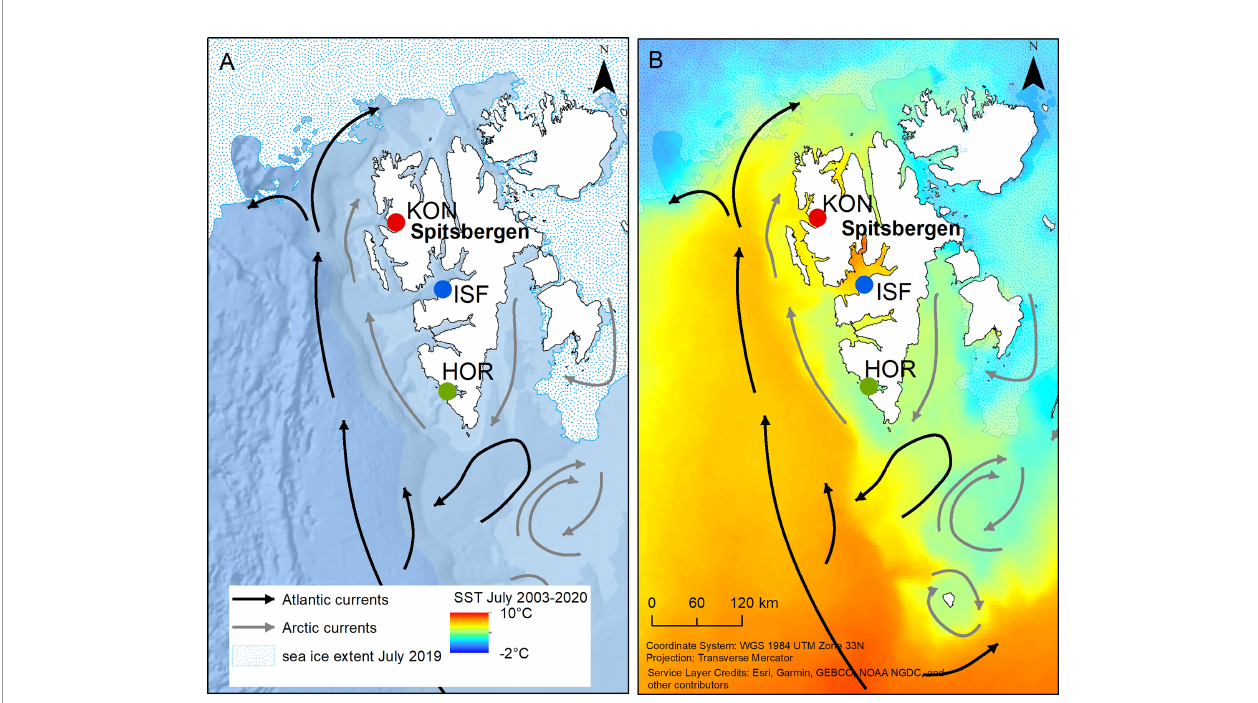
FIGURE 1 | Study sites on Svalbard. A map showing studied little auk colonies (KON – Kongsfjorden, ISF – Isfjorden, HOR – Hornsund), bathymetry (source: Arctic Ocean Base, https://services.arcgisonline.com/arcgis/rest/services/Polar/Arctic_Ocean_Base/MapServer) and July sea ice extent [example for July 2019; source: Multisensor Analyzed Sea Ice Extent - Northern Hemisphere (MASIE-NH), Version 1 with 4 km grid cell size (National Ice Center (NIC) and NSIDC, 2010)] (A) and SST in July in 2003-2020 (source: Moderate-resolution Imaging Spectroradiometer (MODIS) Aqua satellite data from Ocean Color Data webpage, https://oceandata. sci.gsfc.nasa.gov/MODIS-Aqua) and the main Atlantic and Arctic currents in West Spitsbergen (after Loeng and Drinkwater, 2007) (B) .